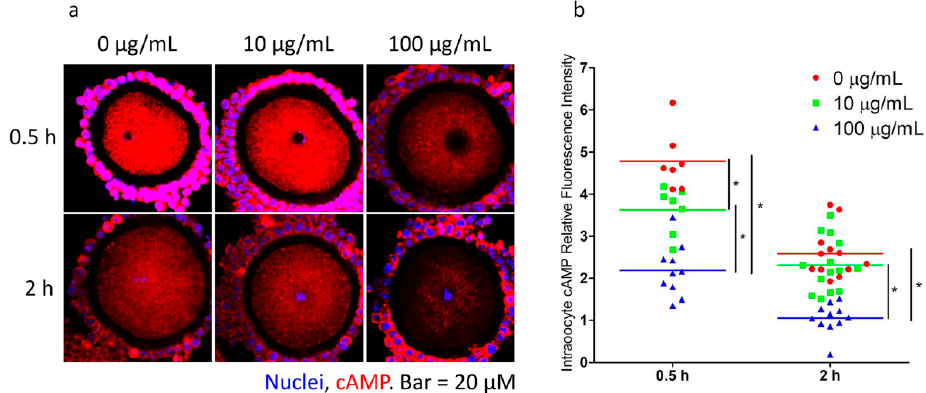
Figure 4. Immunofluorescent analysis of cyclic adenosine monophosphate (cAMP) in oocytes (red, scale bar: 20 μ m). Oocyte-granulosa cell complexes (OGCs) were cultured in M2 medium with different concentrations of fullerenol (0, 10, and 100 μ g/mL) for 0.5 and 2 h and then fixed. ( a ) Representative images of cAMP in OGCs; ( b ) Quantitative analysis of intraoocyte cAMP fluorescence intensity ( n = 7–14 oocytes). Blue and red color indicate nuclei staining and cAMP, respectively. Experiment was performed three times with similar results; * p < 0.05 compared with the indicated groups.